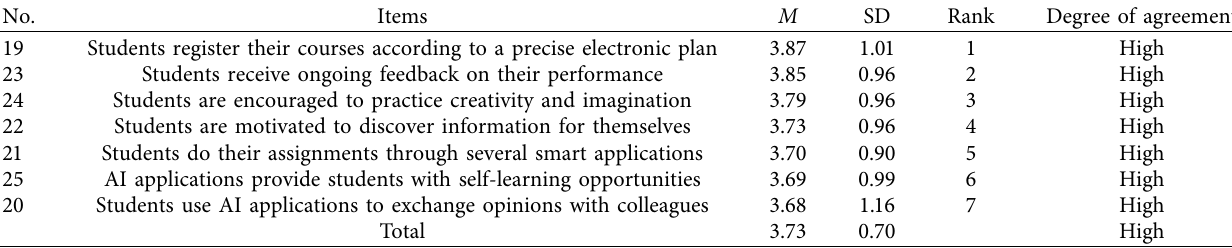
Table 7: Descriptives of the “students” subdimension in descending order.